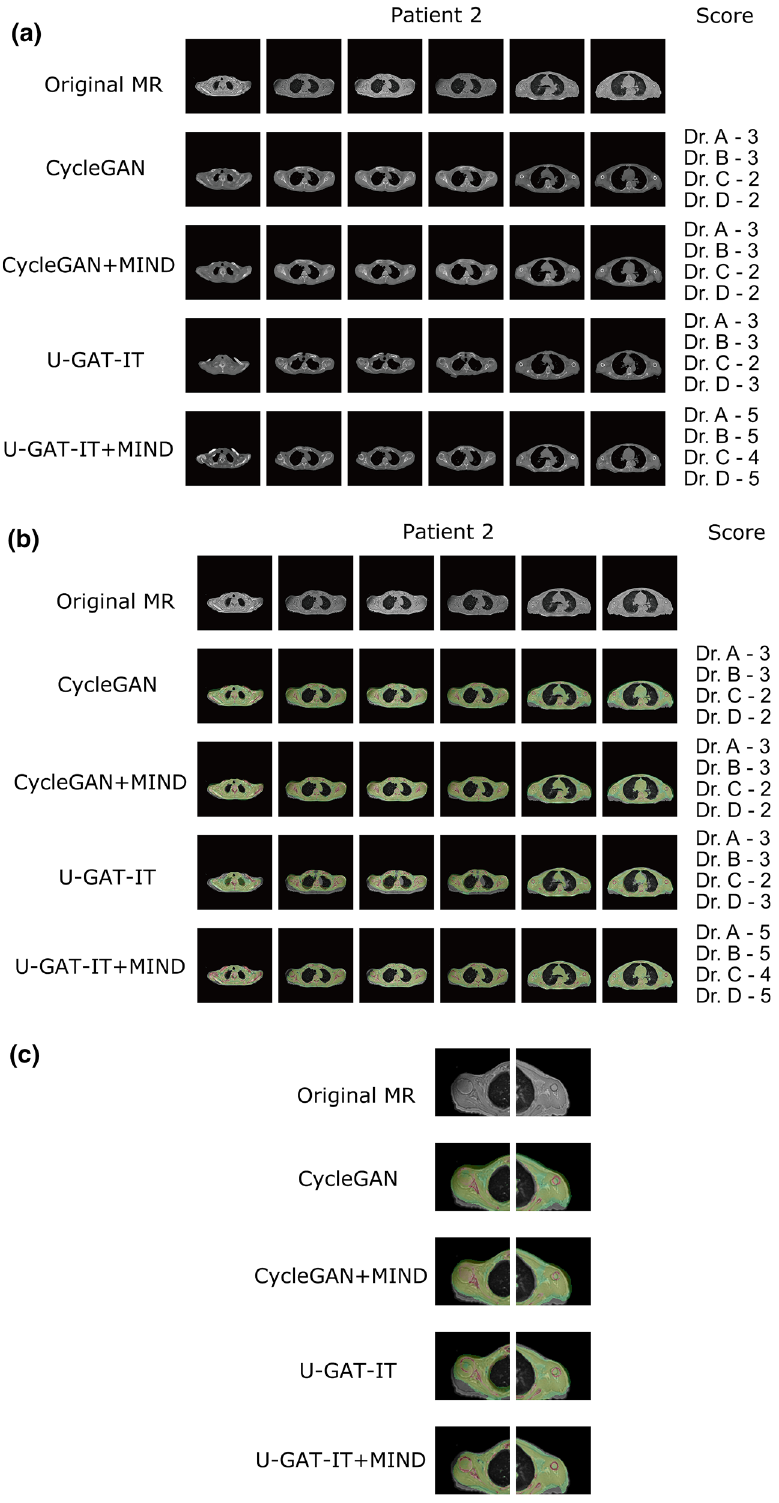
Figure 4. Original MR and synthesised CT images along with visual evaluation scores for Patient 2. ( a ) Original MR and synthesised CT images. ( b ) Original MR and fused images obtained from MR and synthesised CT. ( c ) Cropped images around the humerus in the original MR and fused images obtained from MR and synthesised